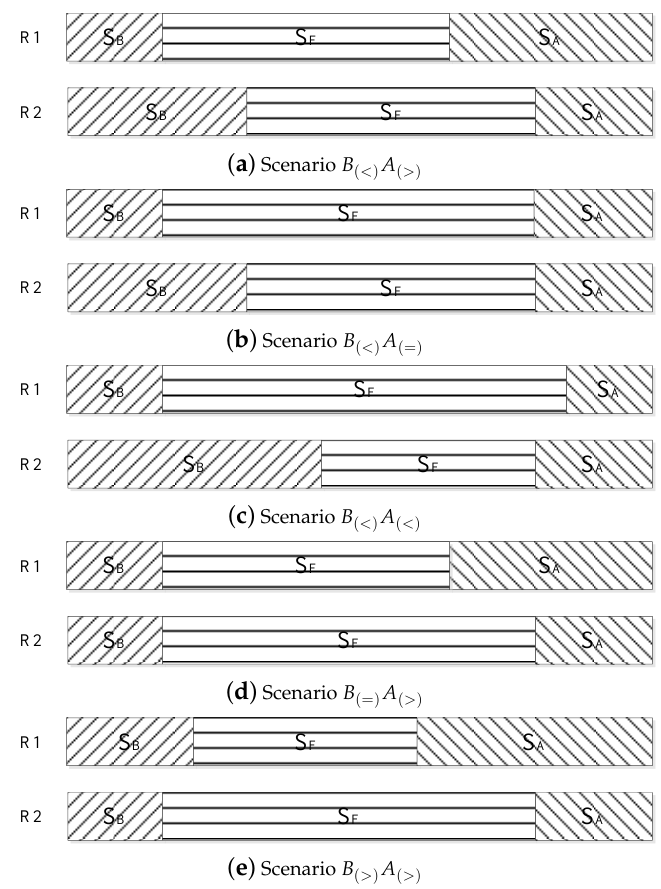
Figure 3. Five scenarios for R 1 performs better than R 2